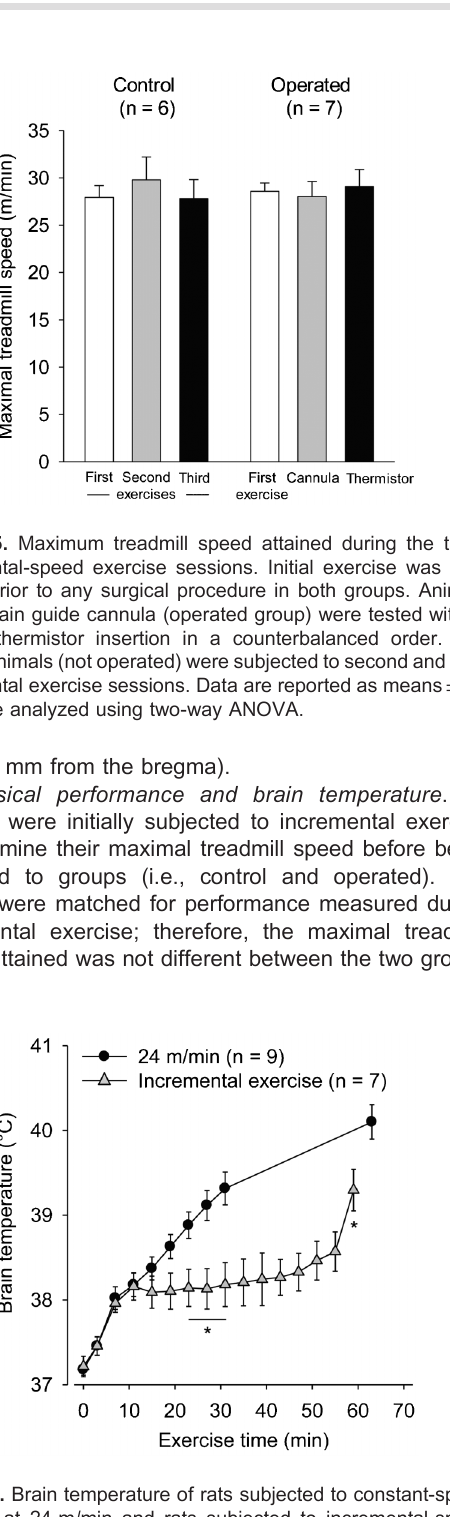
Figure 6. Brain temperature of rats subjected to constant-speed exercise at 24 m/min and rats subjected to incremental-speed exercise. Data are reported as means±SE and were analyzed using two-way ANOVA. *P , 0.05 compared with constant-speed exercise at 24